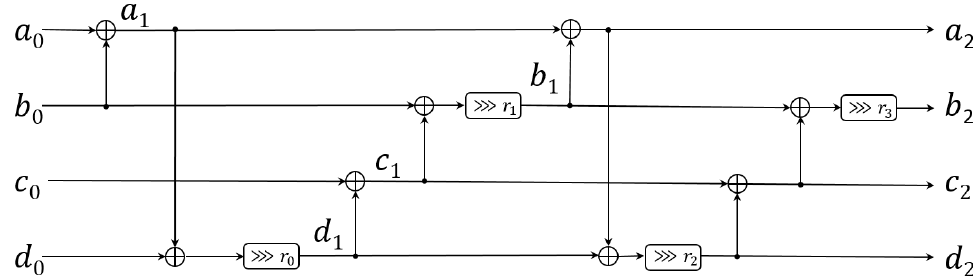
Figure 3: Linear approximation of the G